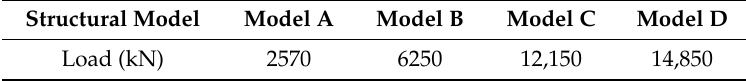
Table 2. The load on hydraulic support calculated by mathematical equation.